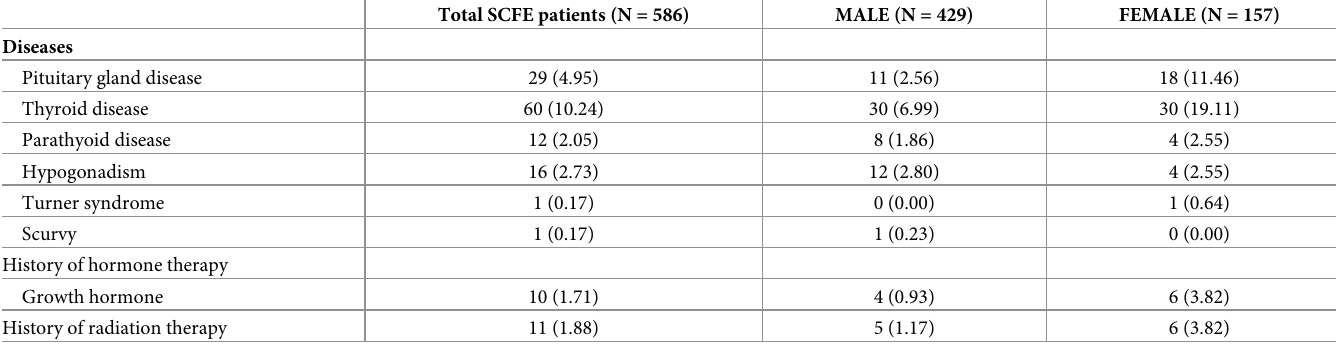
Table 1. Diseases and history of hormone and radiation therapy in SCFE